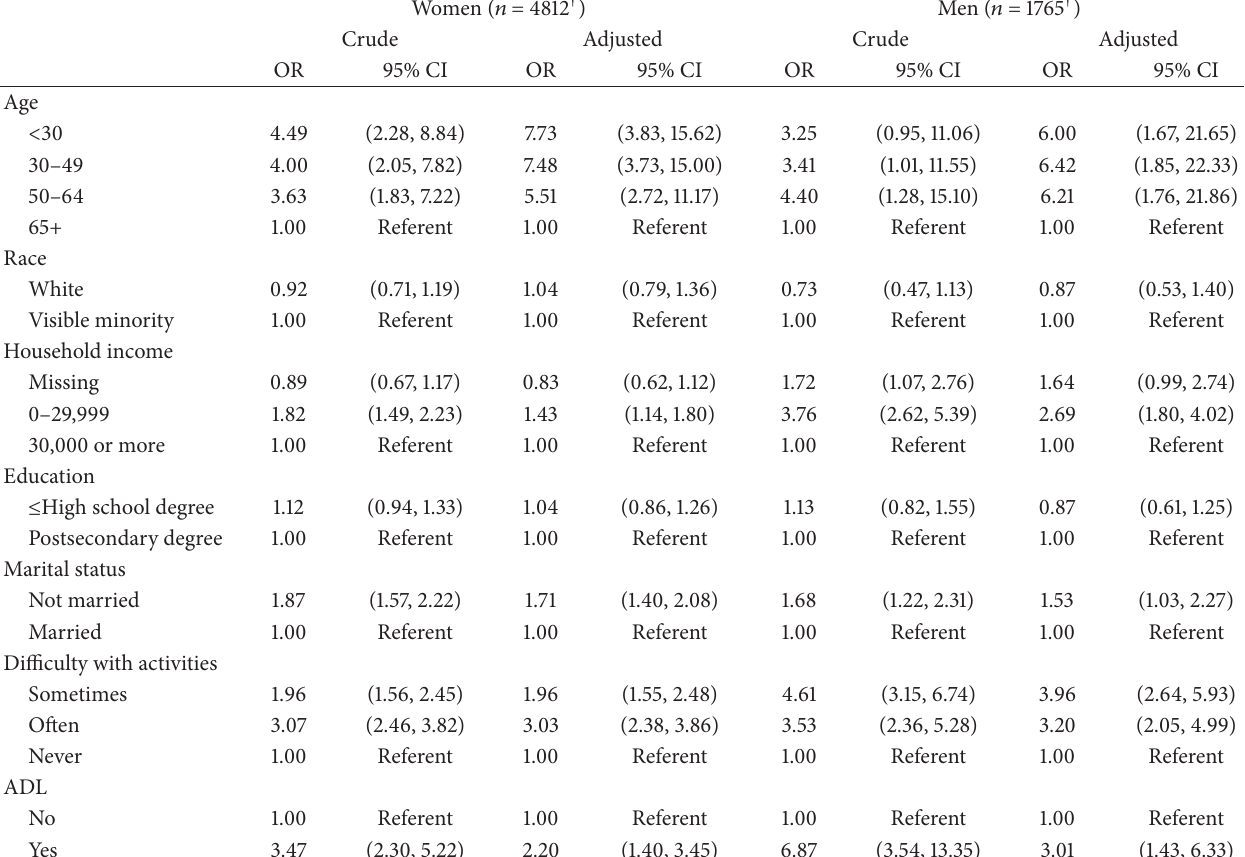
Table 2: Gender-specific crude and adjusted odds of depression among those with